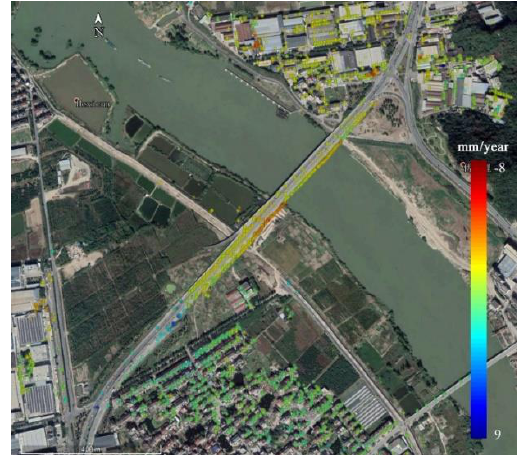
Figure 4. The deformation velocity difference diagram of the same PS points between the method in this paper and the result of point selection based on amplitude information